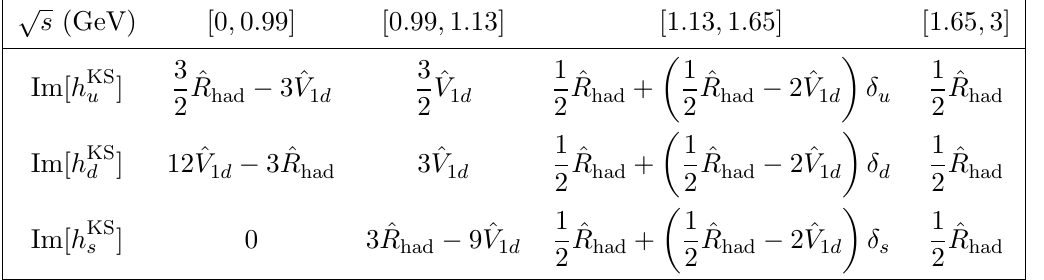
and further 0 s